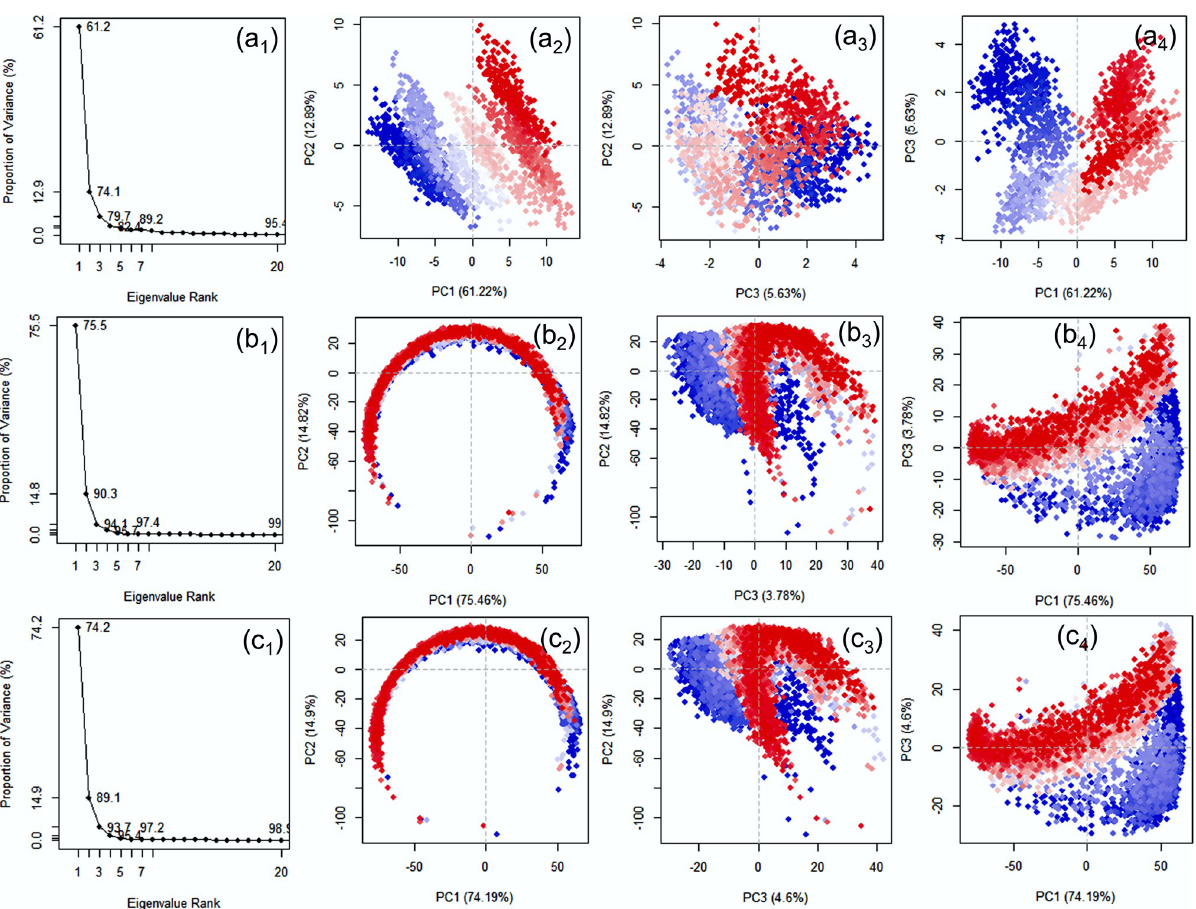
Fig 5. Principal component analysis for the simulation trajectories at 200K (a 1 -a 4 ), 300K (b 1 -b 4 ), and 310K (c 1 -c 4 ). In the sub-figures (a 1 , b 1 , c 1 ), the X-axis (Eigenvalue Rank) represents the principal components (PCs) while Y-axis represents the percentage of total variance explained by each individual principal component. The scatter plots represent the distribution of extracted essential motion between two PCs while colour change from red to blue through white marks for the periodic fluctuations experienced by the residue during 100 ns MD simulation.